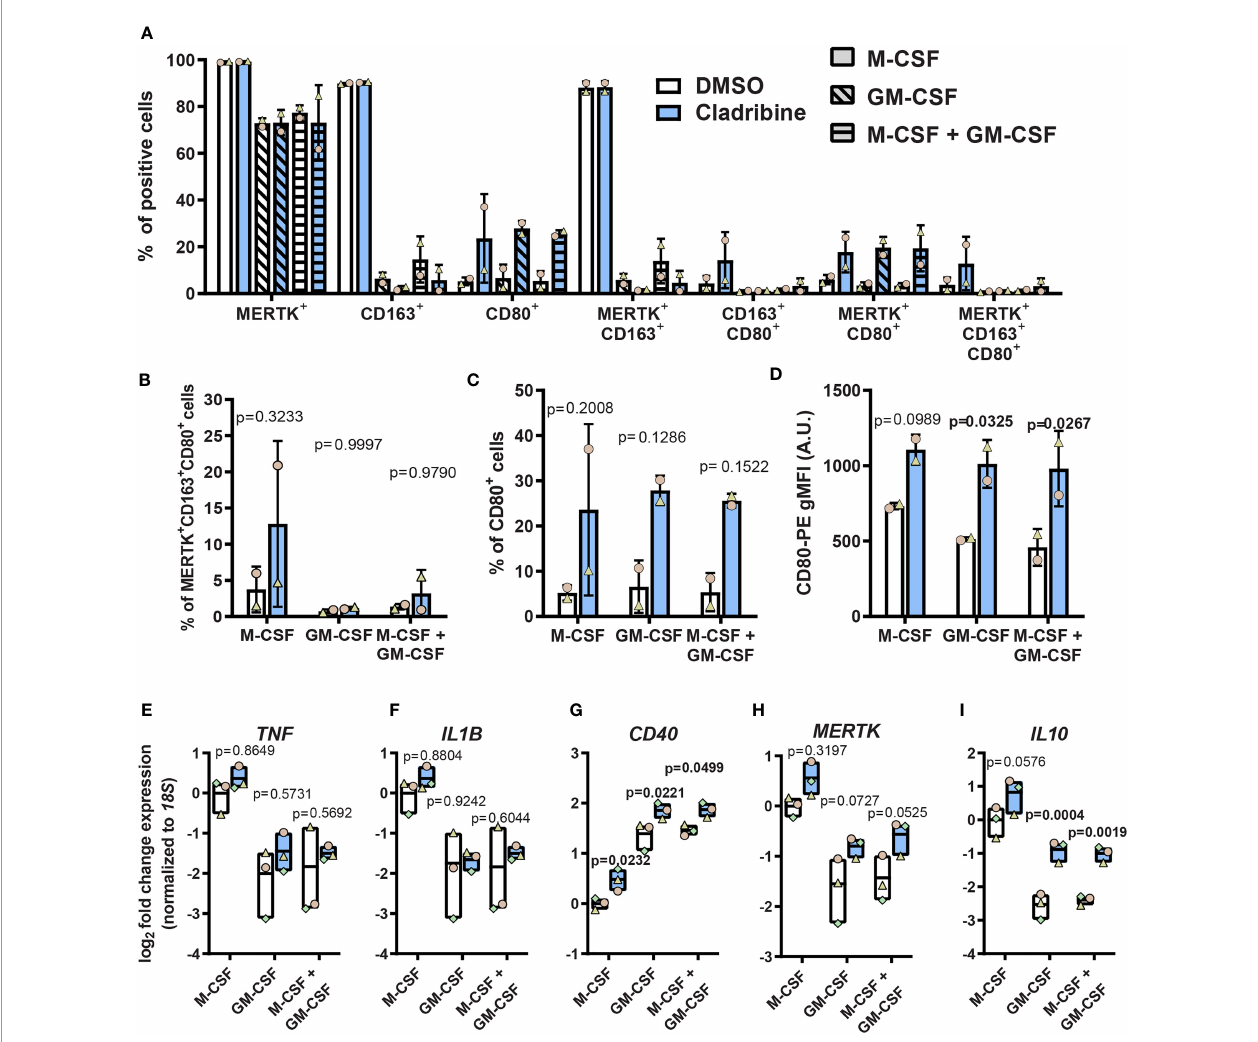
FIGURE 4 | Expression of activation markers in monocyte-derived macrophages (MDMs) treated with cladribine in vitro . Monocytes isolated from healthy donors were differentiated to MDMs with M-CSF and/or GM-CSF in the presence of cladribine. (A – C) Percentage of MDMs expressing pro-in fl ammatory (CD80) and anti- in fl ammatory (CD163 and MERTK) activation markers at day 6 of cladribine treatment in vitro as analyzed by fl ow cytometry. Positive cells were determined according to their fl uorescent minus one (FMO) control. (D) Levels of CD80 surface protein expression on MDMs treated with cladribine during differentiation in vitro , as analyzed by fl ow cytometry. (E – I) RT-qPCR gene expression analysis of (E – G) pro-in fl ammatory and (H, I) anti-in fl ammatory activation markers at day 6 post cladribine treatment in vitro . (A – C) Positive cells were determined according to FMO controls. (A – D) Data depicted as mean (with SD) and symbols indicate matched experiments from the same healthy donor ’ s sample, n=2. p-values between cladribine 0.05 m M and vehicle (DMSO) were determined by ordinary two-way ANOVA with Sidak ’ s posthoc test. (E – I) Data depicted as mean (with max-min) and symbols indicate matched experiments from the same healthy donor ’ s sample, n=3. p-values between cladribine 0.05 m M and vehicle (DMSO) were determined by ordinary two-way ANOVA with Sidak ’ s posthoc